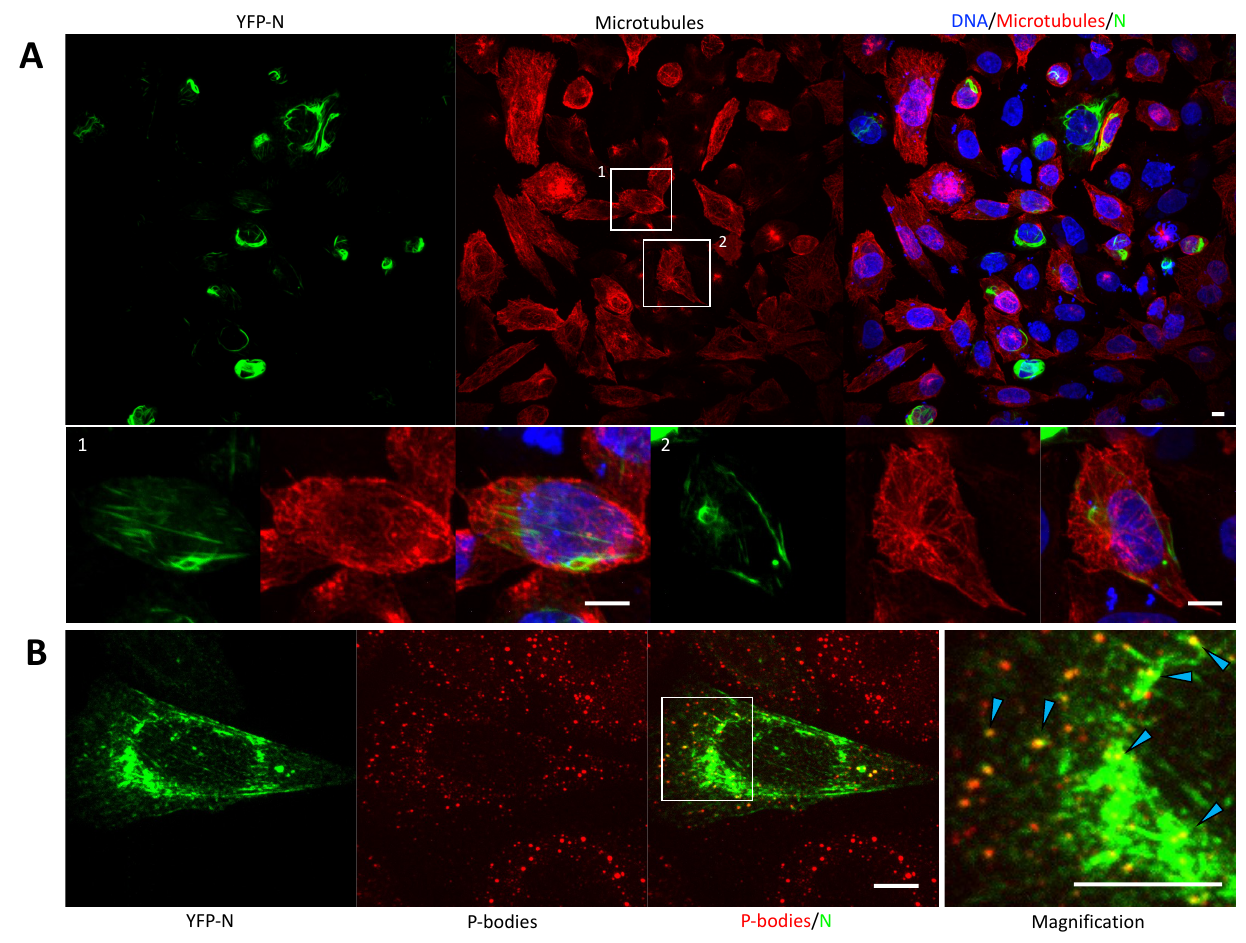
Figure 3. YFP-N co-localizes with P-bodies. ( A ) CHO-K1 cells were transfected with YFP-N and stained 24–48 h p.t. for microtubules by immunofluorescence. The two boxed cells are shown magnified in the lower panel. ( B ) CHO-K1 cells were transfected with YFP-N and stained for P- bodies by immunofluorescence using anti-Dcpa1 antibodies. A magnification of the boxed area is shown on the right. Punctate patterns with clear co-localization of P-bodies and YFP-N are highlighted with arrows. All images show maximum intensity projections of z-stacks. Scale bars: 10 µ m. Additional examples can be found in the